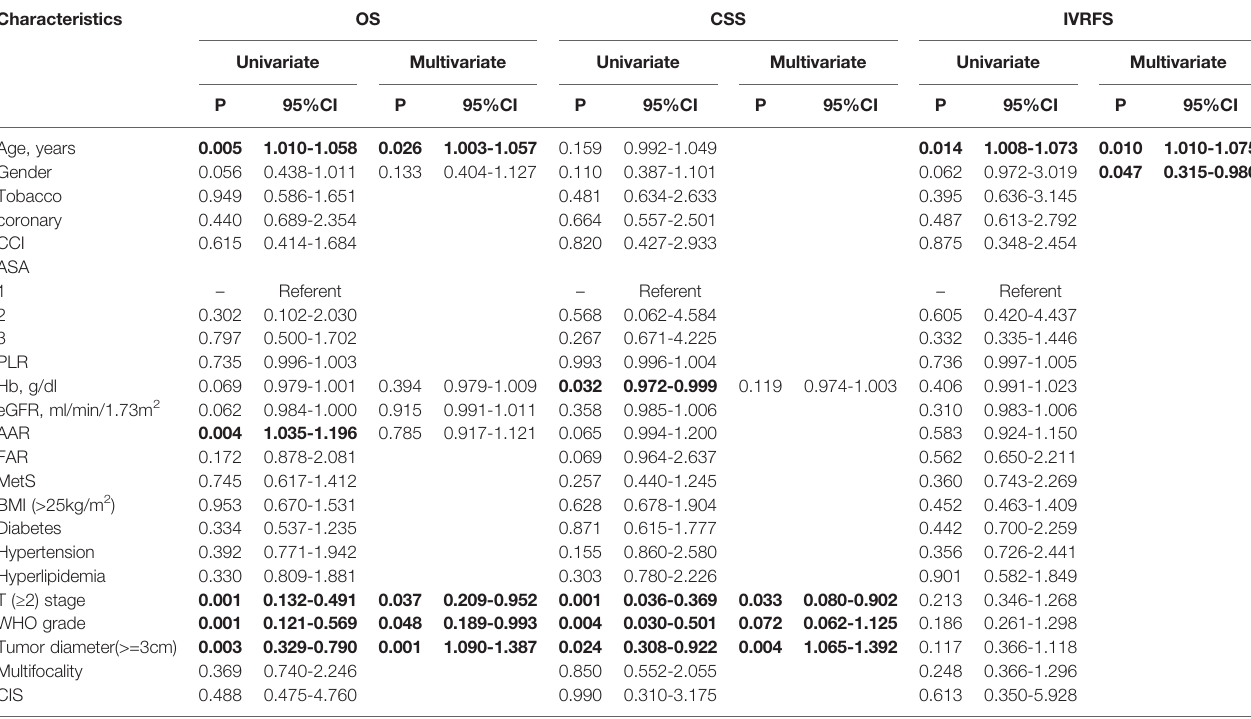
TABLE 4 | Univariate and multivariate cox regression analyses for OS, CSS and IVRFS after propensity score matching.